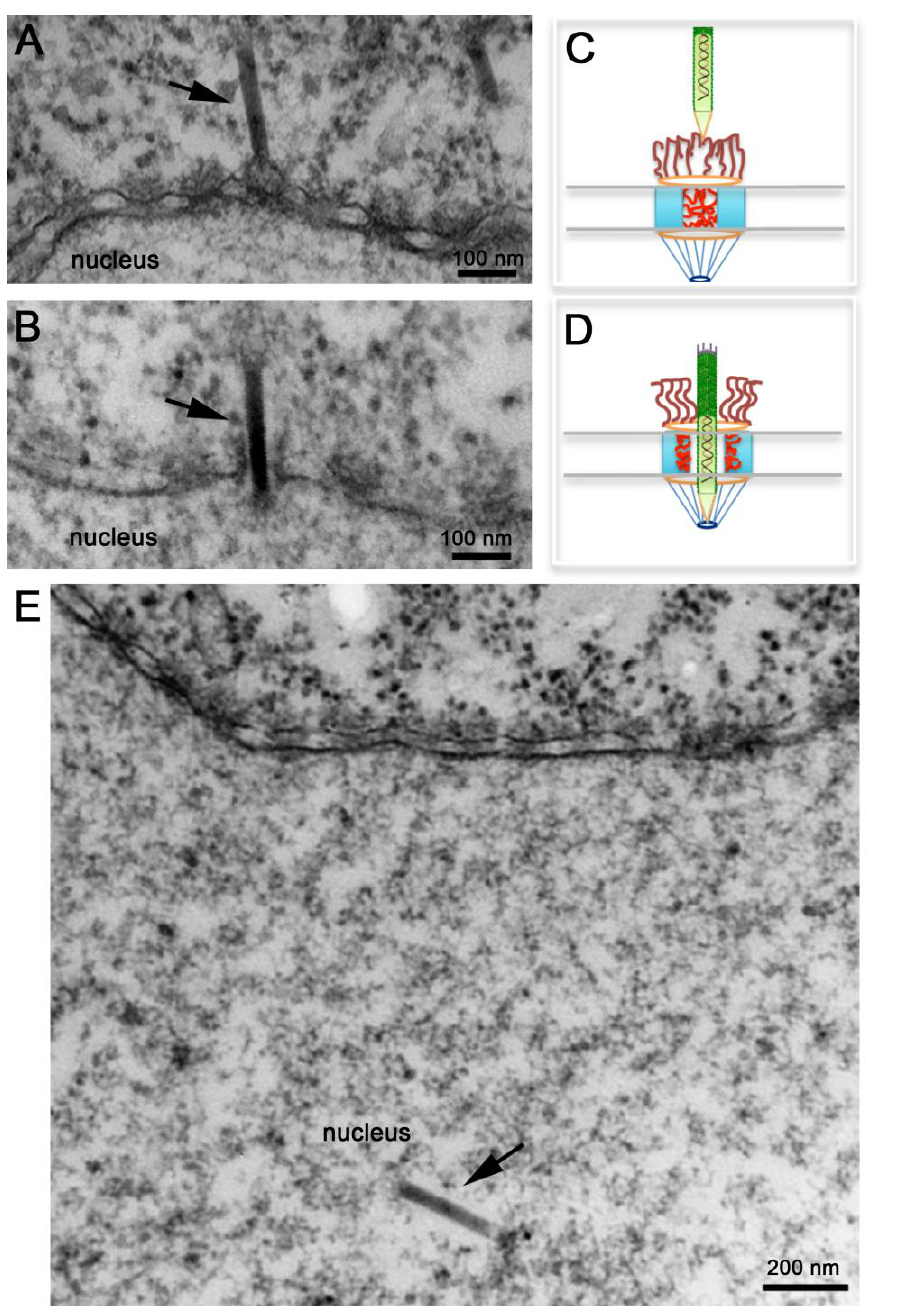
Figure 4. Nuclear import of AcMNPV Nucleocapsids. Electron micrographs of nuclear envelope cross-sections from Xenopus oocytes that have been microinjected with AcMNPV nucleocapsids and processed for embedding and thin-section electron microscopy. Intact nucleocapsids (arrows) were detected docked at the nuclear pore complex (NPC) prior to nuclear import ( A ), midway through the NPC ( B ), and inside the nucleus ( E ). ( C , D ) Schematic diagrams of NPCs illustrating “close” and “open” states respectively. In ( C ) NPC cytoplasmic filaments and nucleoporins within the central channel prevent the passage of the nucleocapsid. In ( D ) NPC cytoplasmic filaments straighten out, and nucleoporins in the central channel retract towards the body of the NPC to free up the passageway for the nucleocapsid to cross the